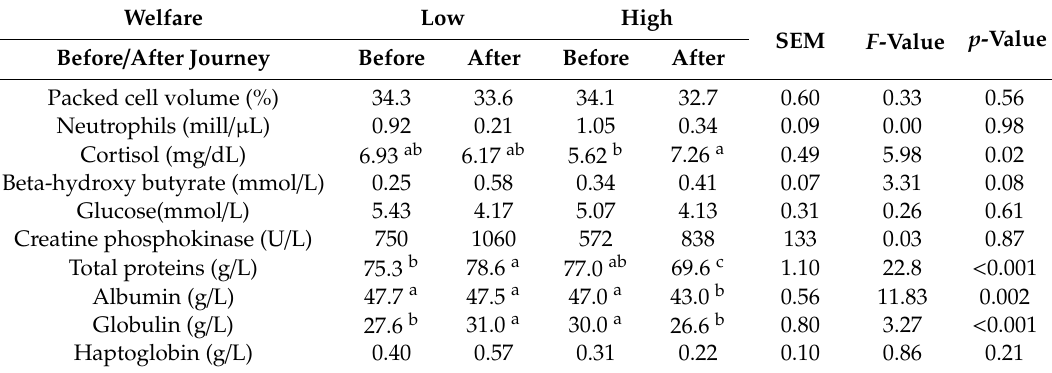
Table 4. Means of blood variables of cattle subjected to long distance transport and interactions